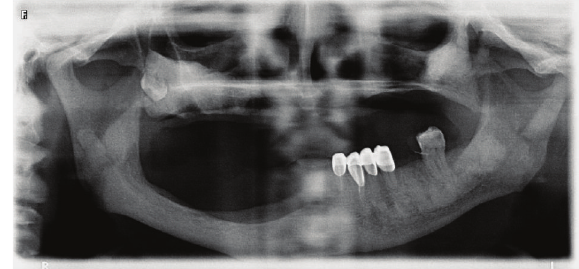
Figure 2: Panoramic radiograph showing osteomyelitis in the right mandibula due to extraction of the right mandibular second molar tooth.